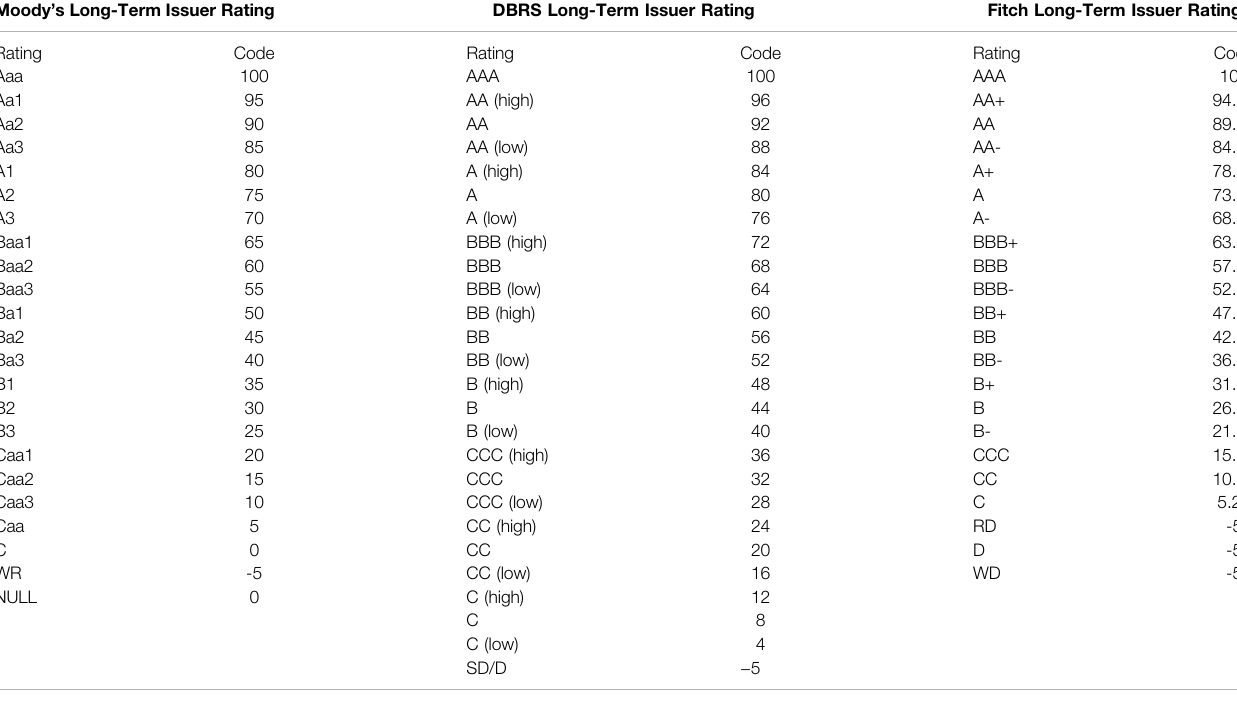
TABLE 2 | Decomposition of Moody ’ s, Dominion Bond Rating Service, and Fitch long-term issuer credit ratings.